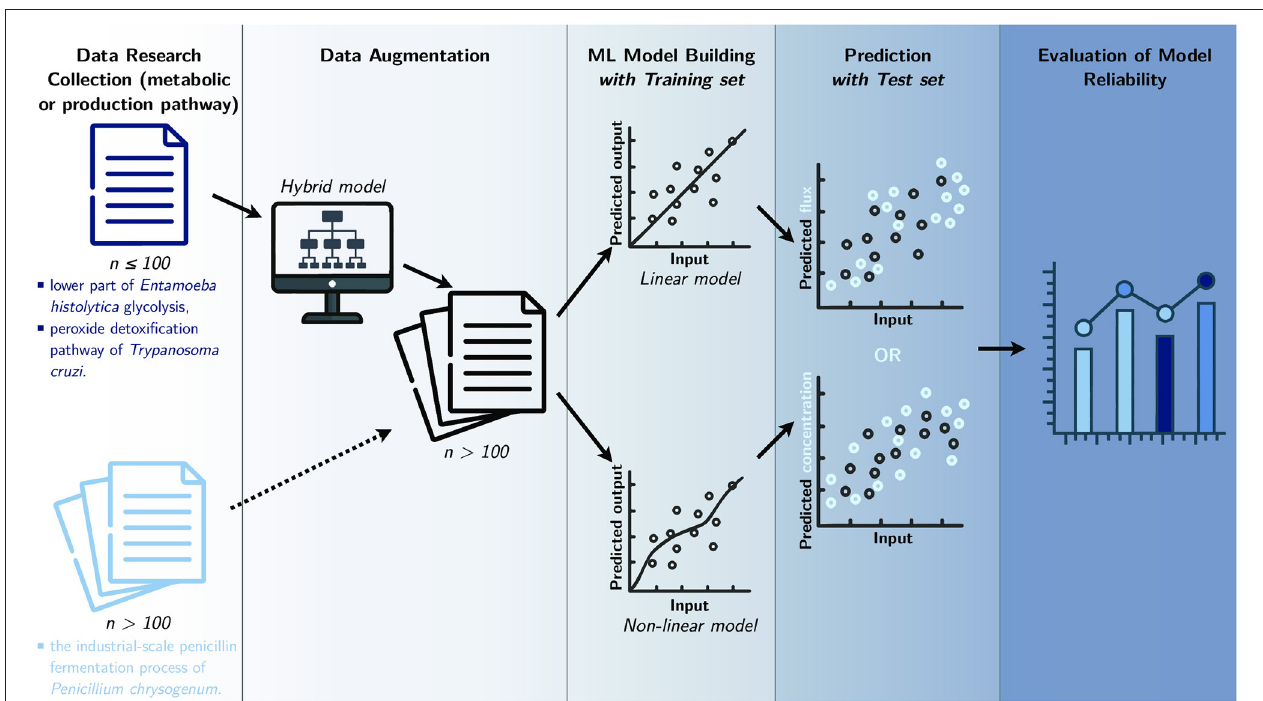
FIGURE 2 | Study workflow. Data from three different metabolic pathways are collected and used to build data-based models. Datasets that contain a small amount of data ( n ) go through a process of data augmentation, before being separated into two sets: training set and test set. Then, in order to predict the final flux or final product concentration, multiple ML models are built with the training set, while the test set is used to assess the final models. The resulting predictions are compared in a last step to evaluate model